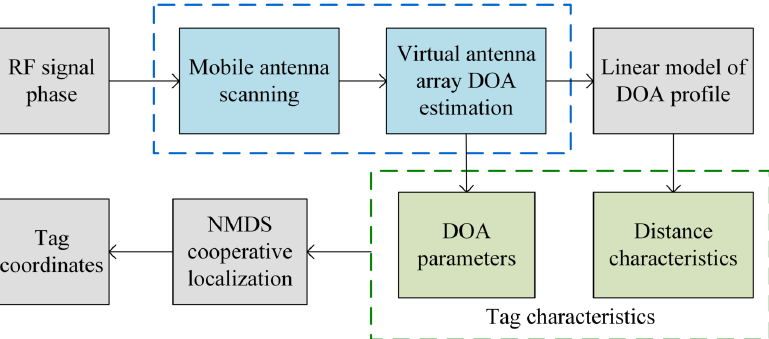
Figure 3. Flow chart of hybrid DOA estimation and NMDS cooperative multi-target localization system.